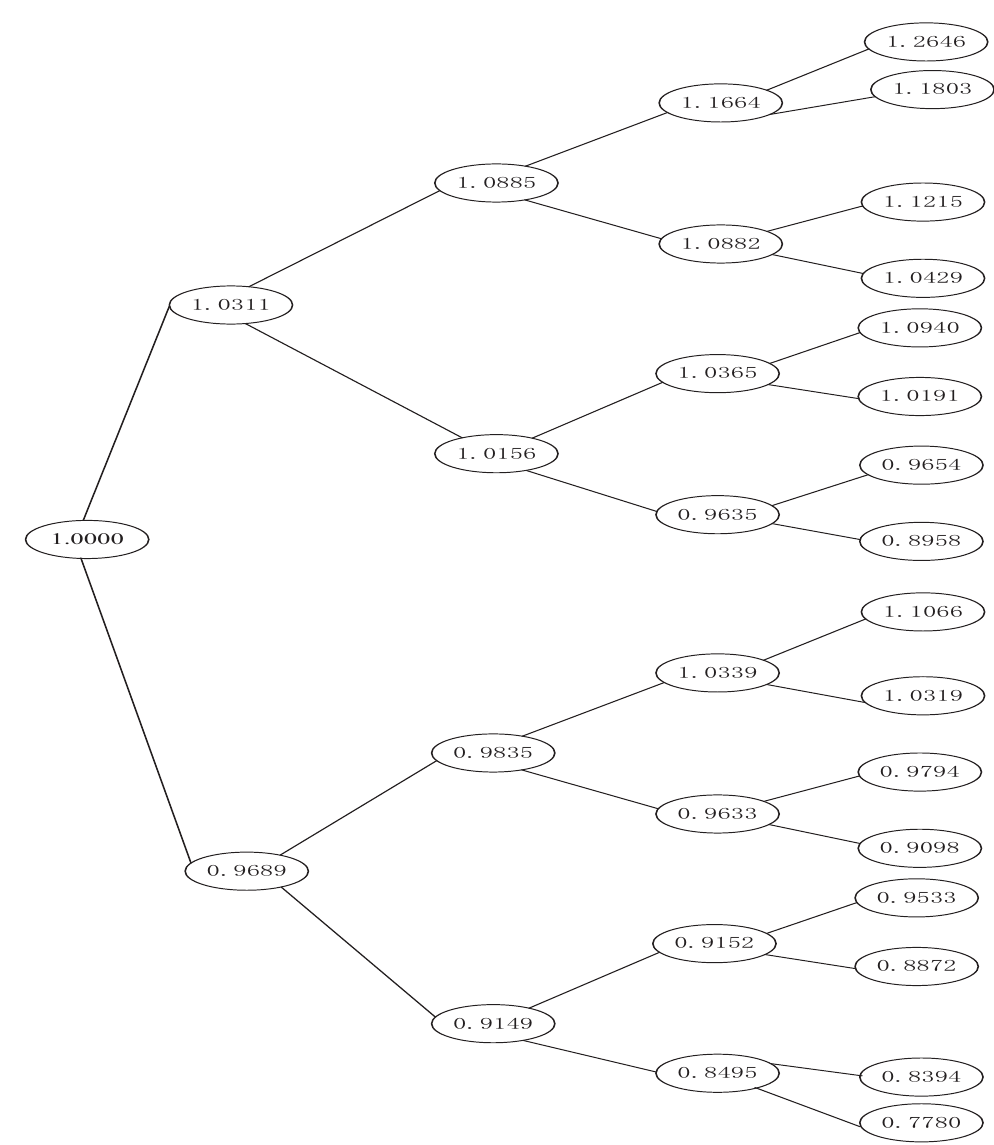
Figure 2. A four-step Hermite binomial tree with arbitrage, H = 0.85 and k =